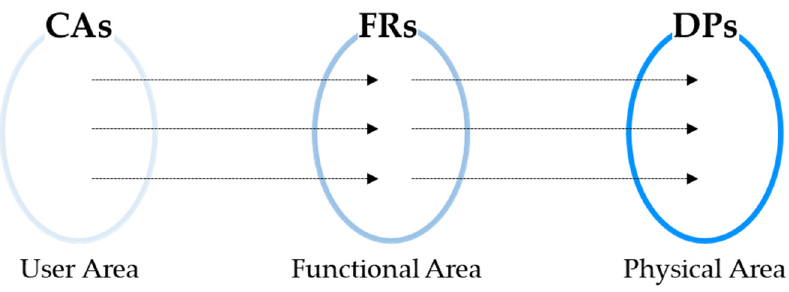
Figure 2. Areas of product development p rocess .